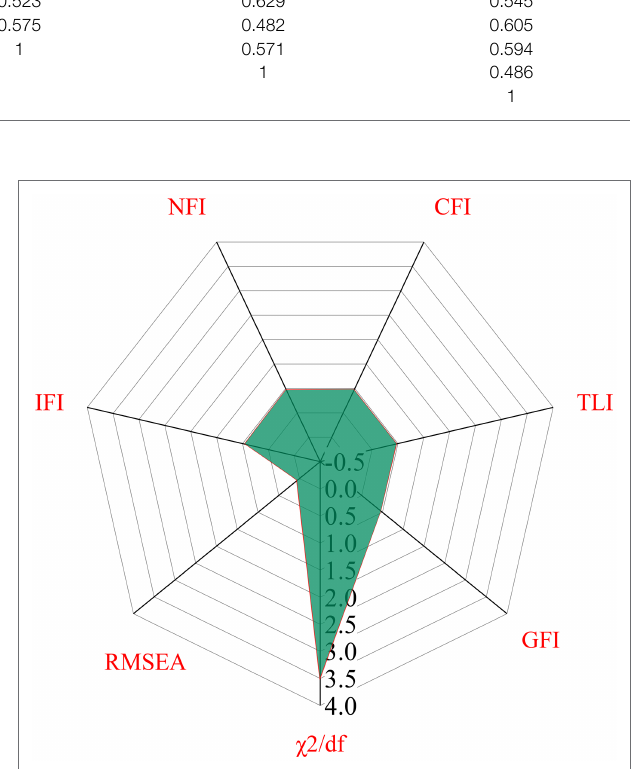
FIGURE 11 | Radar distribution map of model fitting index. GFI, Goodness Fit Index; TLI, Tucker Lewis Index; CFI, Compare Fitting Index; NFI, Normed Fit Index; IFI, Incremental Fit Index; RMSEA, Root Mean Square Error Approximate; χ 2 /df, Chi-square/degree of